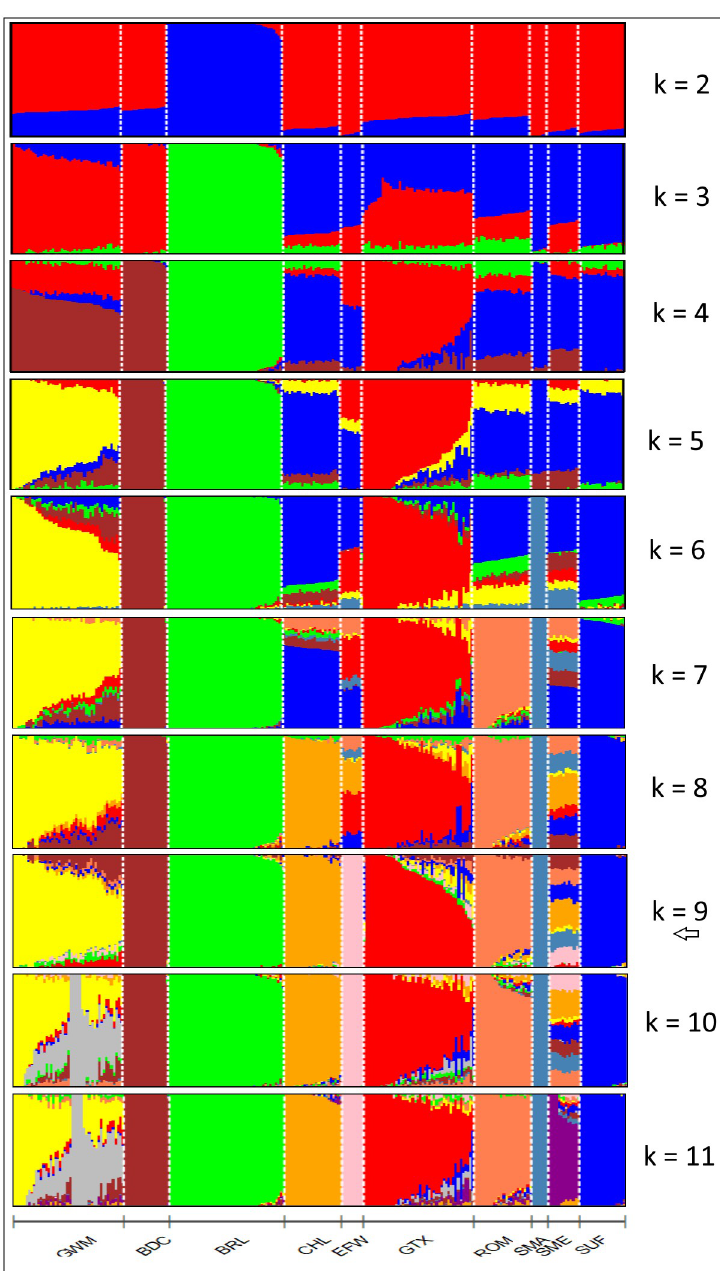
Fig 7. Admixture analysis of 10 sheep breeds. Results are presented for k = 2–11 and the optimal number of clusters (k = 9) is indicated with an